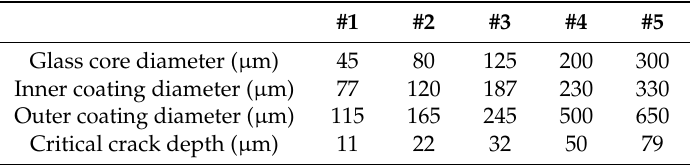
Table 1. Geometry parameters of the five optical fibers and critical crack depths.